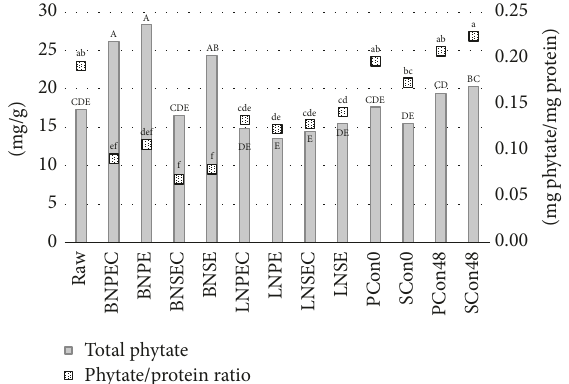
Figure 5: Total phytate and phytate/protein ratio for select samples. B: baker’s yeast; L: L. kononenkoae ; N: nitrogen supplement; P: pasteurized; S: sterilized; E: enzyme; C: coculture. Same letters are not significantly different, 𝑝 < 0.05